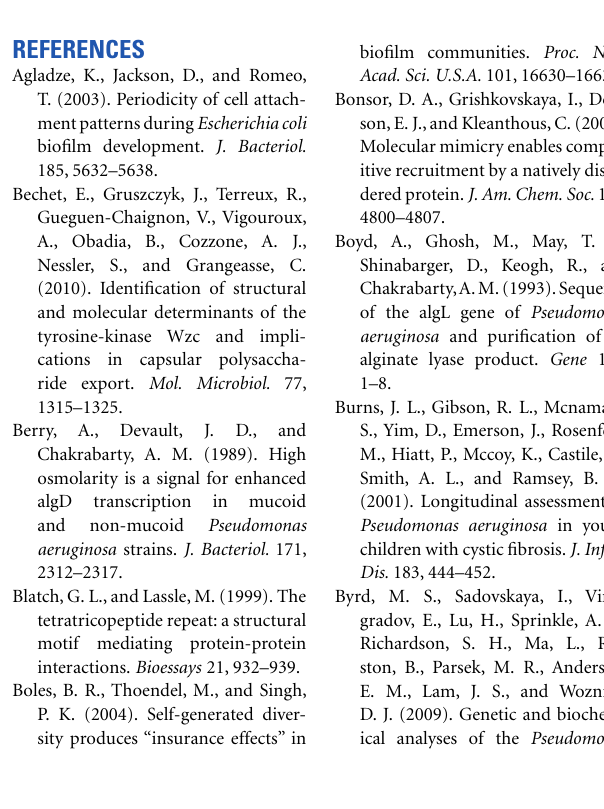
FIGURE 7 |Atomic force microscopy images of hydrated P. aeruginosa FRD1 and FRD11131 algD ::Tn501 biofilm cells, collected at 90% humidity. (A) When living at an air/water interface, FRD1 is able to maintain its shape during dehydration. (B) FRD1131 biofilm cells dry out quickly and collapses under the same conditions. Once dry, the extracellular polymer is removed from FRD1 by imaging, but the surface of the FRD1 cells is distinct from